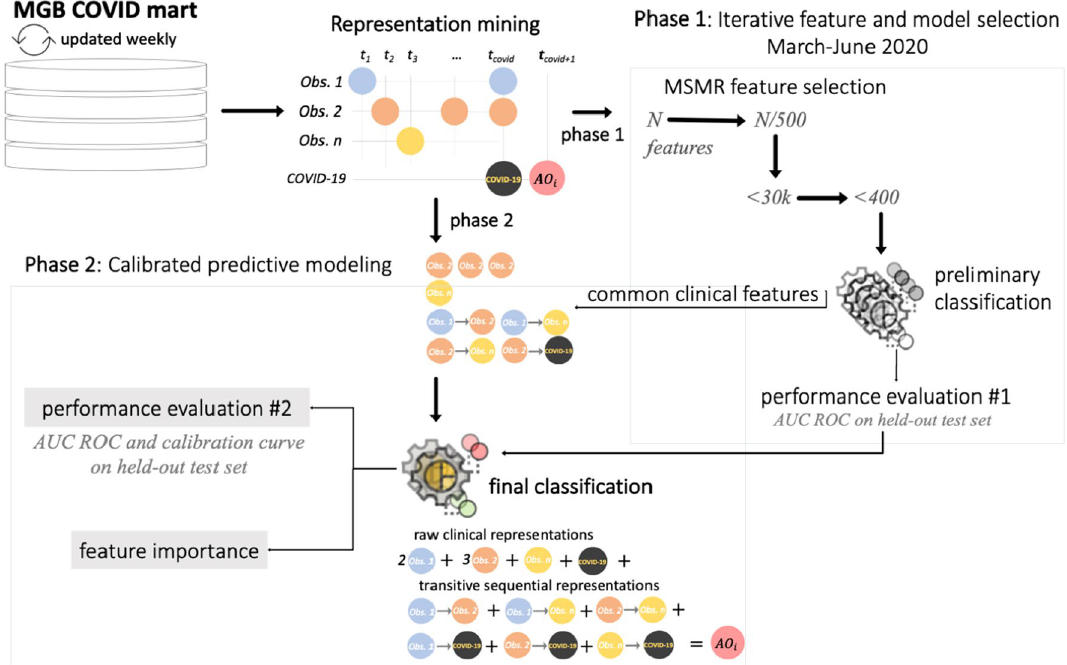
Figure 4. Implementation of the MLHO framework for predicting COVID-19 adverse